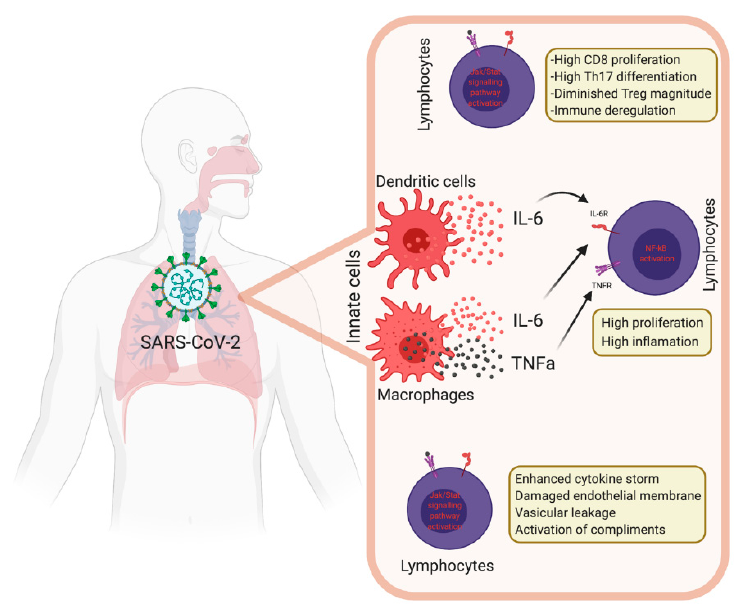
Figure 4. Immune dysregulation mechanisms during coronavirus disease 2019 (COVID-19).